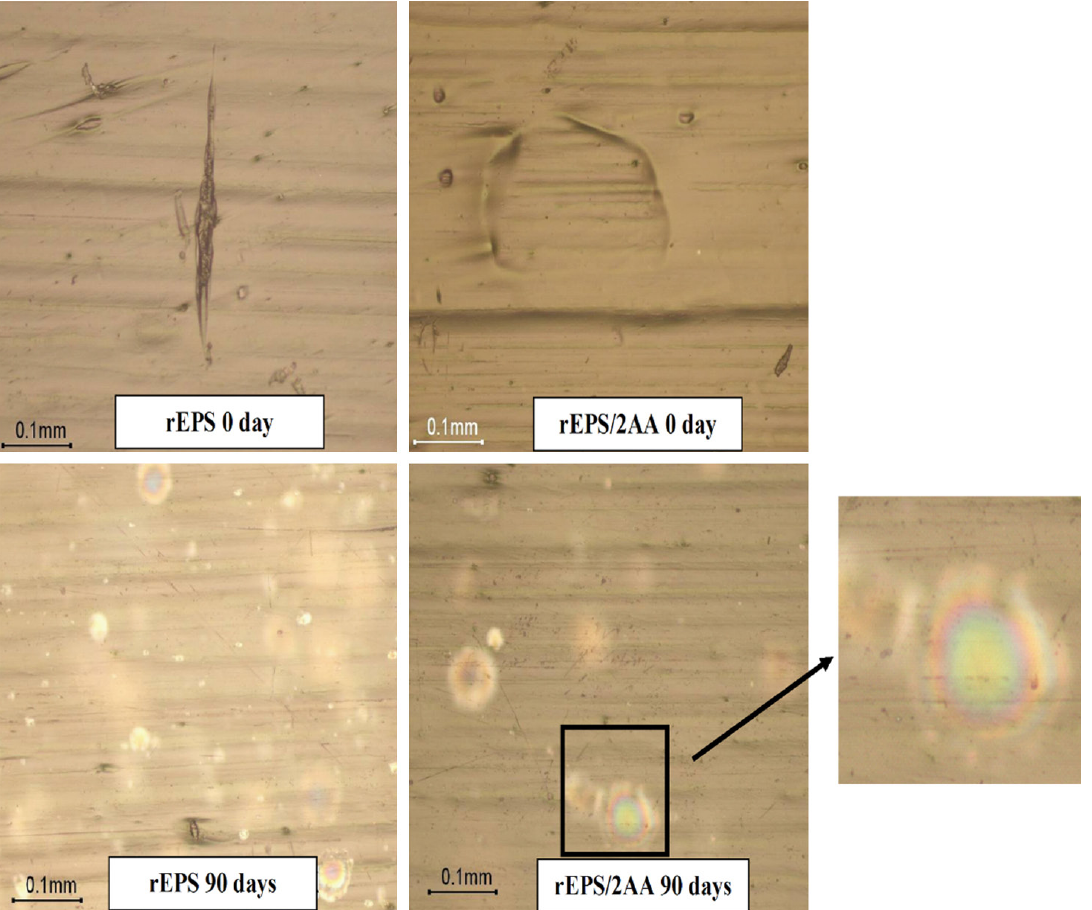
Figure 3. Optical micrographs of the surfaces of the samples without fiber before exposure (above) and after 90 days of exposure (below) to the simulated soil.